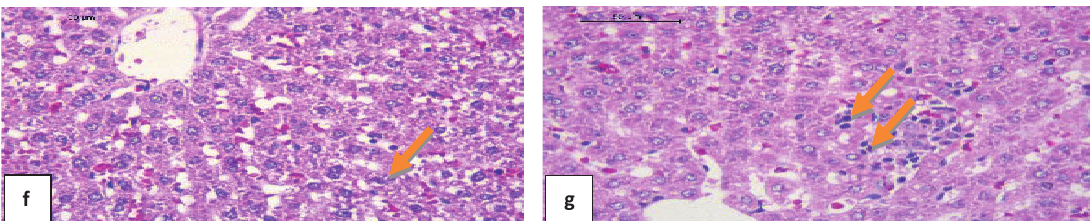
Figure 4. Histopathology of Liver Wistar rat 400x by Hematoksilin Eosin (HE). Comparison between histopathological features positif control group (f), with first treatment group (g). First treatment group seems more inflamatory cells (green arrow) then positif control group.